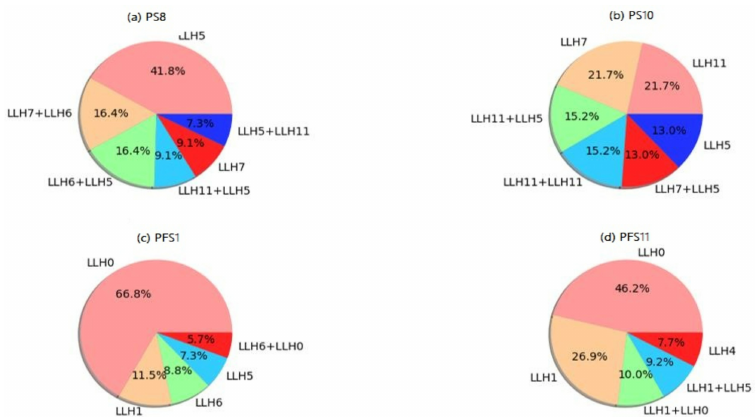
Figure 7. Analysis of two PS and two PFS